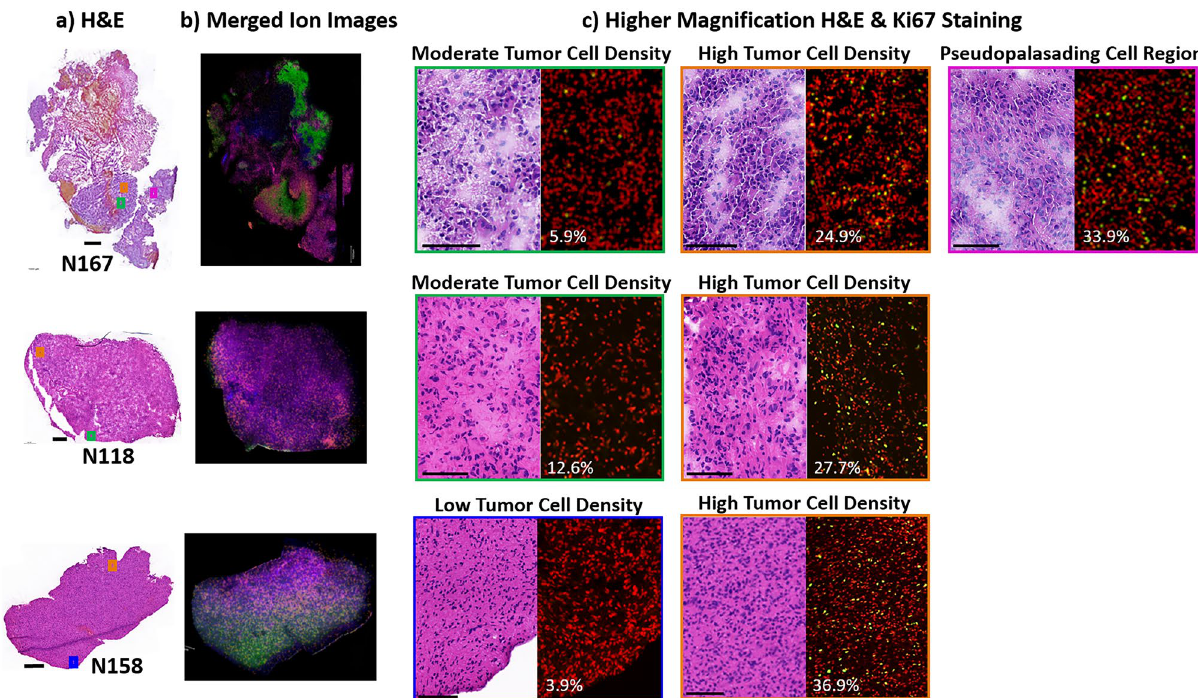
Figure 6. H&E-stained sections, merged ion images, and Ki67 staining with percent labeling index. ( a ) H&E- stained sections. Scale bars are 1 mm for N167 and 500 µm for samples N158 ans N118. ( b ) Merged ion images of GD3(36:1) at m/ z 1470.830 in orange, PI(38:3) at m/ z 887.562 is shown in pink, C1P(34:1) at m/z 616.471 in blue, and ST(42:2) at m/z 888.624 in green. ( c ) Higher magnification H&E images with corresponding Ki67 staining and percent labeling index. Hoechst nuclei (red); Ki67 + nuclei (green). Sections = 10 µm; scale bars are 100